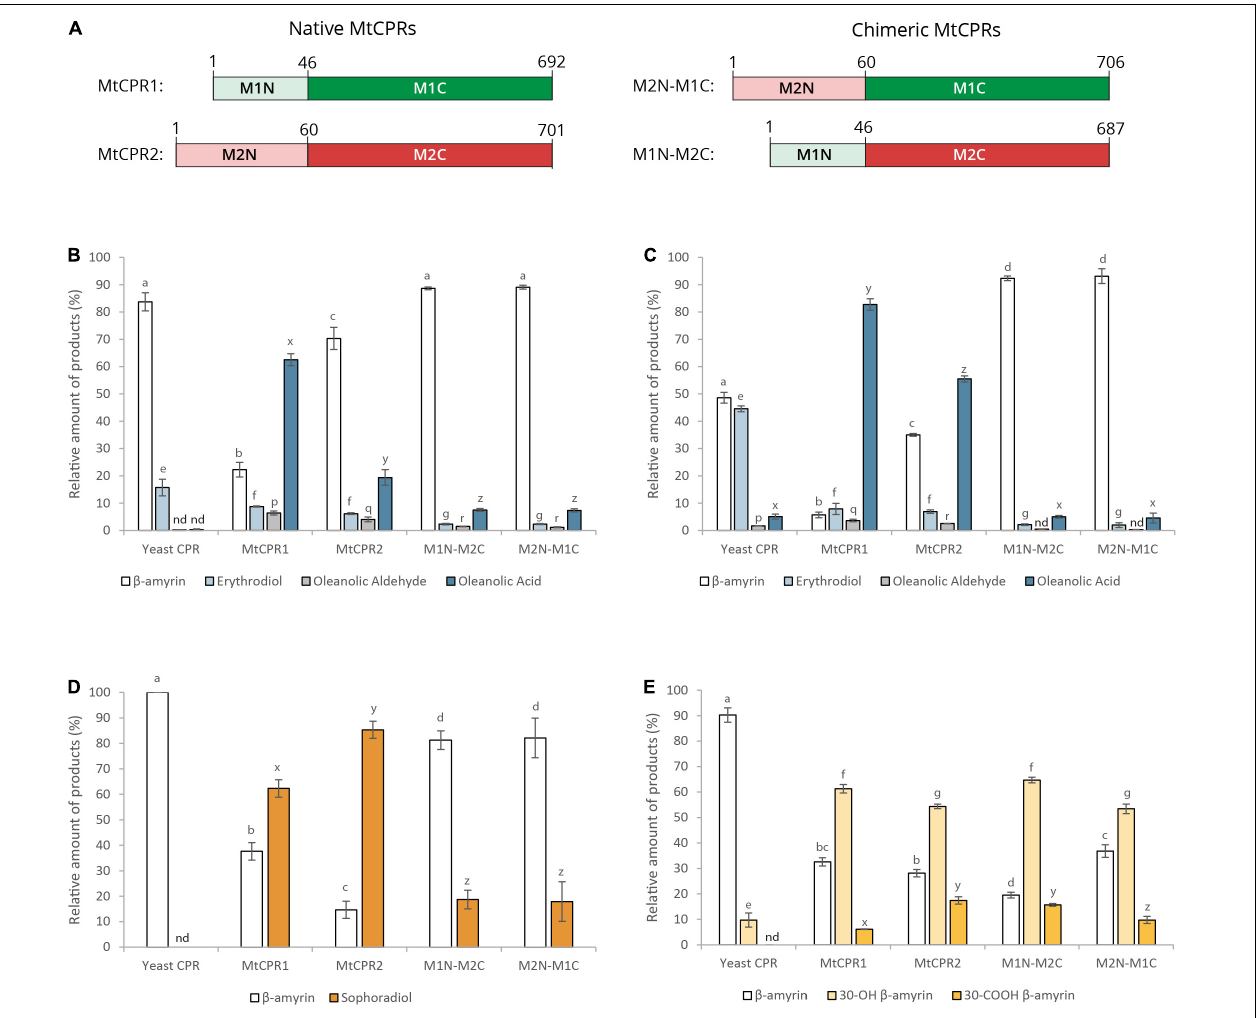
FIGURE 8 | The relative amount of triterpenoid produced by co-expressing different CYPs with N-terminal-swapped chimeric CPRs. (A) N-terminal domain of MtCPR classes I and II were swapped to generate two chimeric CPRs, M2N-M1C, and M1N-M2C. The numbers indicate the position of amino acid residue. These chimeric CPRs were then co-expressed with (B) MtCYP716A12, (C) LjCYP716A51, (D) LjCYP72A61, and (E) MtCYP72A63 in β -amyrin-producing yeast (INV Sc1 strain). Triterpenoids content were measured relative to uvaol as internal standard. Data have been presented as mean ± SE ( n = 3). nd, signal below detection limit. Single-factor ANOVA was used for statistical comparisons. The different letters indicate significant differences ( P < 0.05, one-way ANOVA followed by Tukey’s test). Letter a–d are used to indicate significancy for β -amyrin, letter e–g are for erythrodiol and 30-OH β -amyrin, letter p–r are for oleanolic aldehyde, and letter x–z are for oleanolic acid, sophoradiol, and 30-COOH β